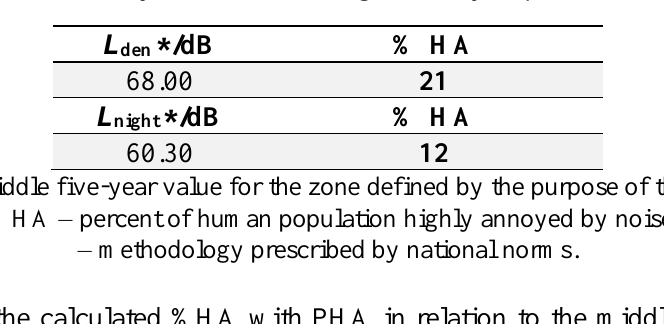
Table 3. Percent of human population annoyed by road traffic noise in the area of the city center and city roads of the City of Novi Sad during the five-year period 2012 − 2016.